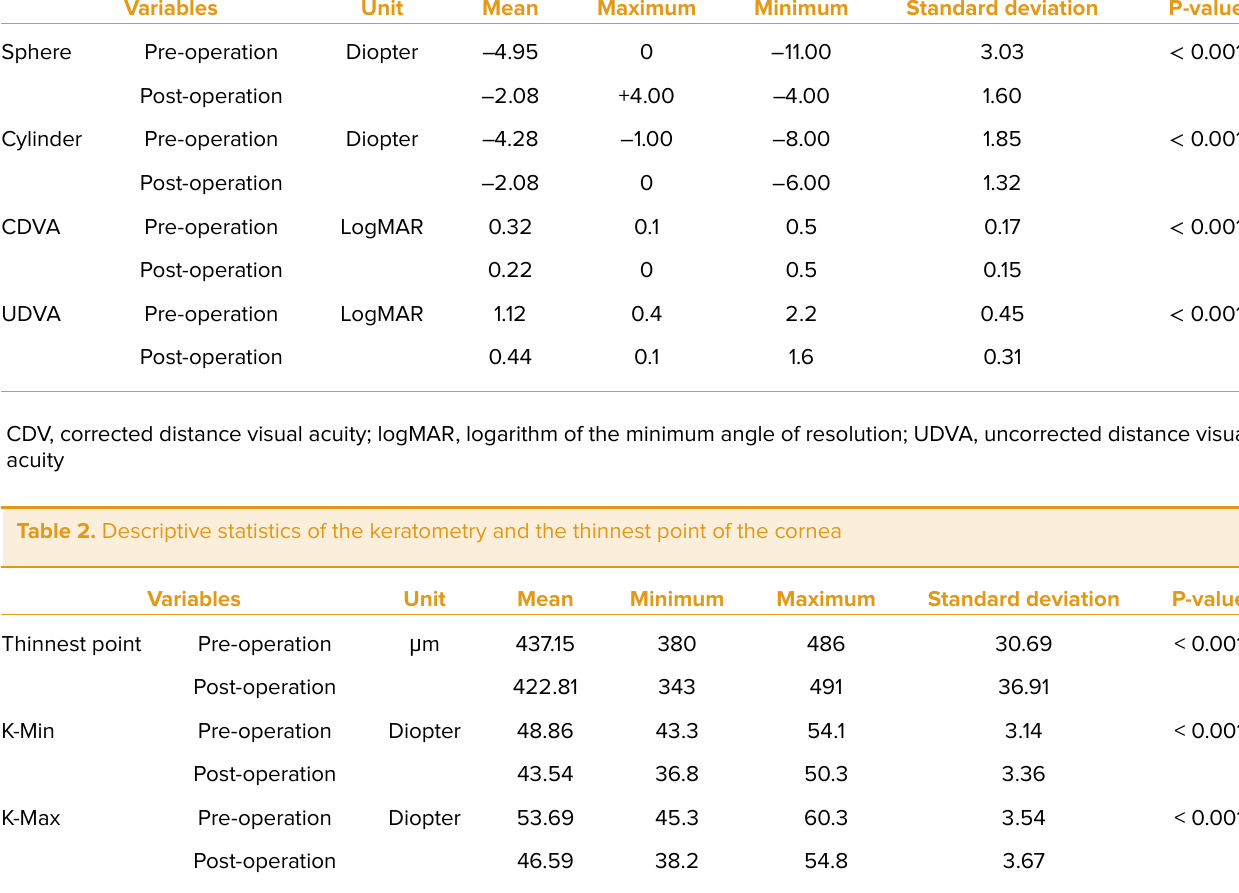
Table 1. Descriptive statistics for refractive errors, the corrected distance visual acuity, and the uncorrected distance visual acuity Variables